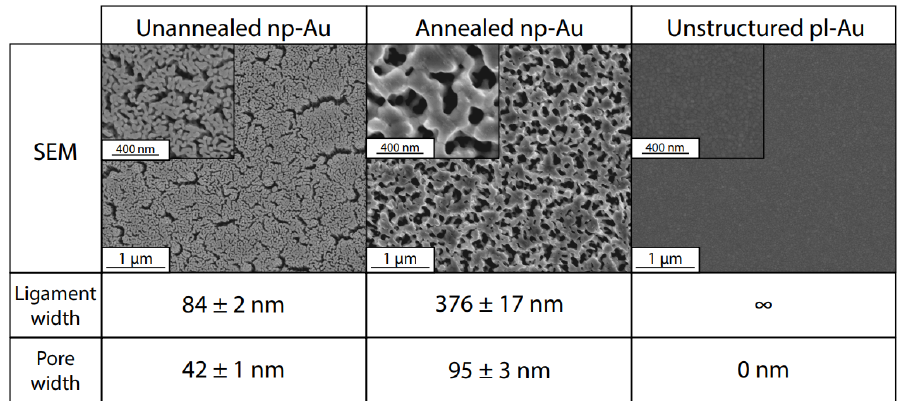
Figure 2. Comparison of morphology of annealed and unannealed nanoporous gold (np-Au) and planar gold (pl-Au). Scanning electron microscopy (SEM) images are shown at 50,000× magnification (inset: 100,000× magnification). Ligament and pore widths are reported as averages ± standard error.